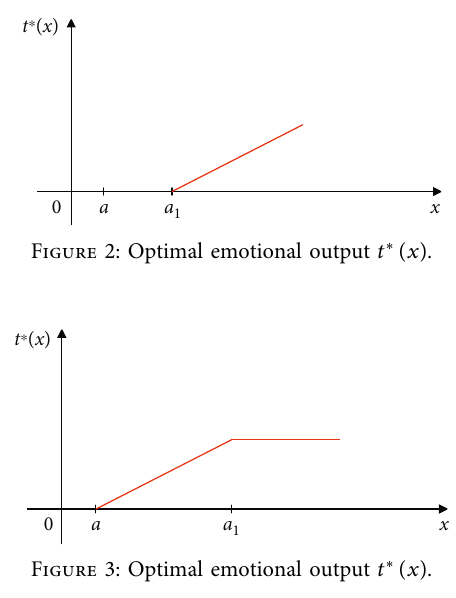
Figure 3: Optimal emotional output t ∗ ( x )